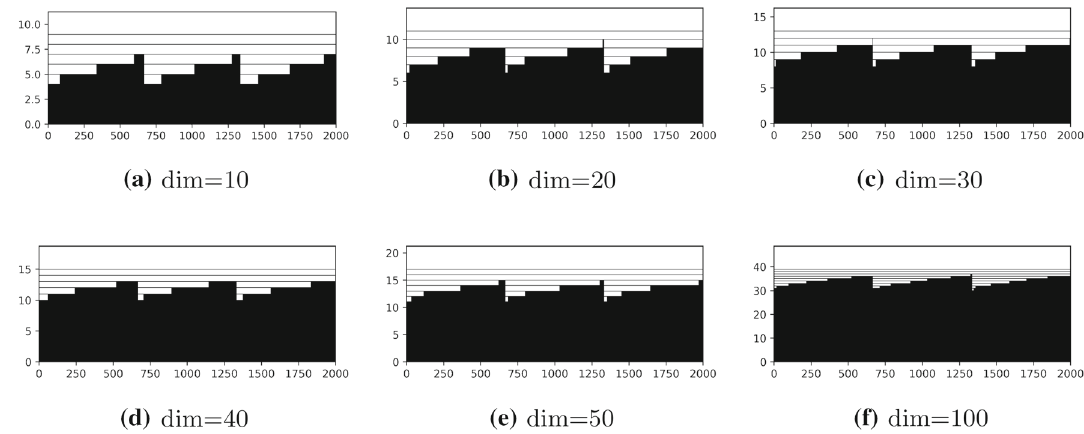
Fig. 11 AMTICS applied to three-blob datasets with multiple